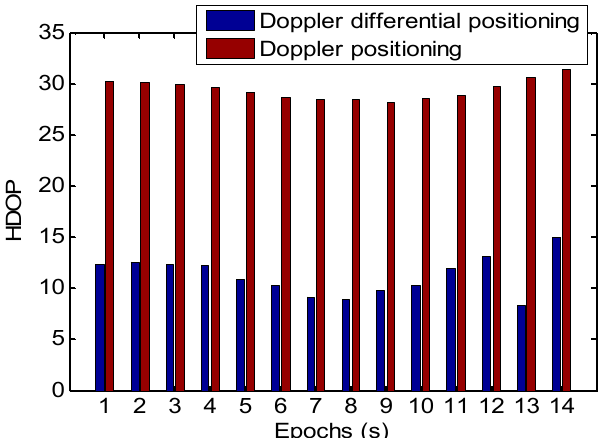
Figure 11. Horizontal dilution of precision (HDOP) on a straight-line trajectory.